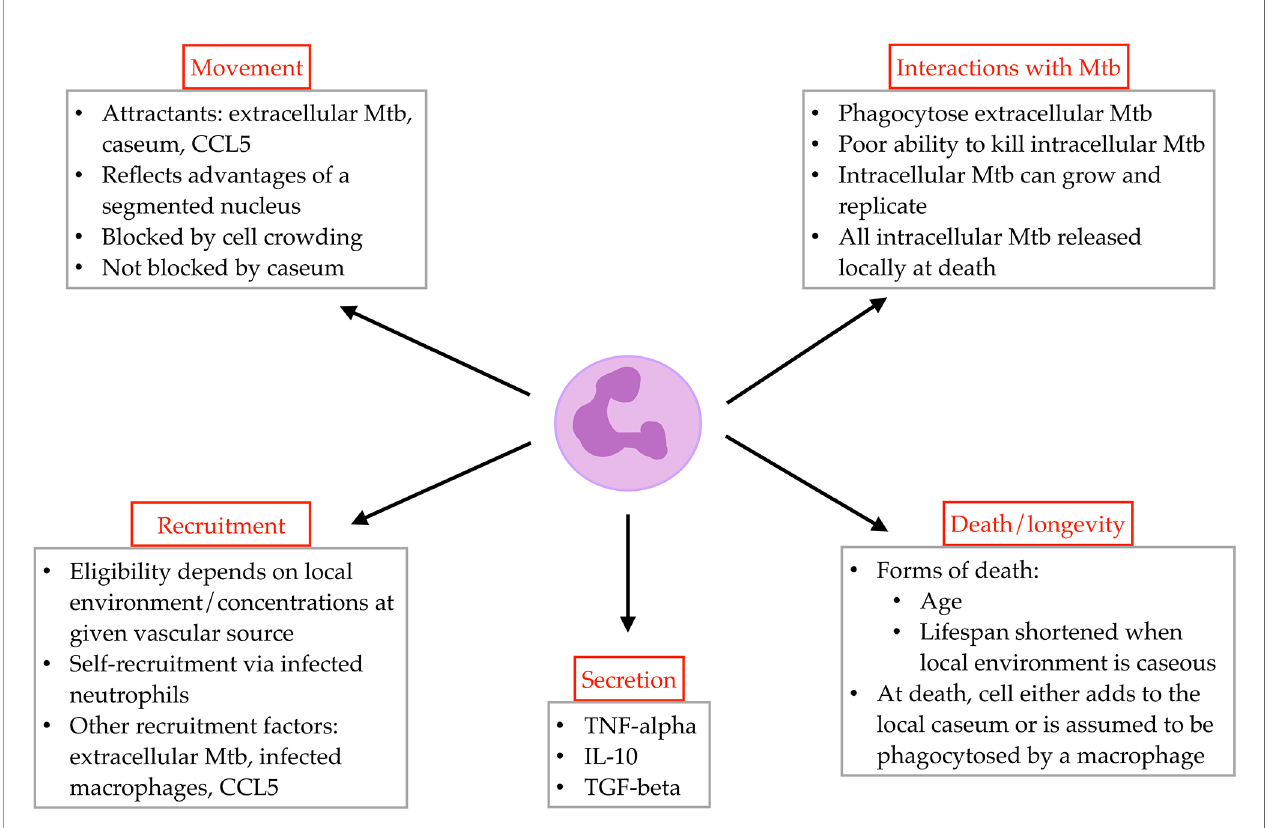
FIGURE 1 | Overview of rules governing neutrophil agent behavior in GranSim